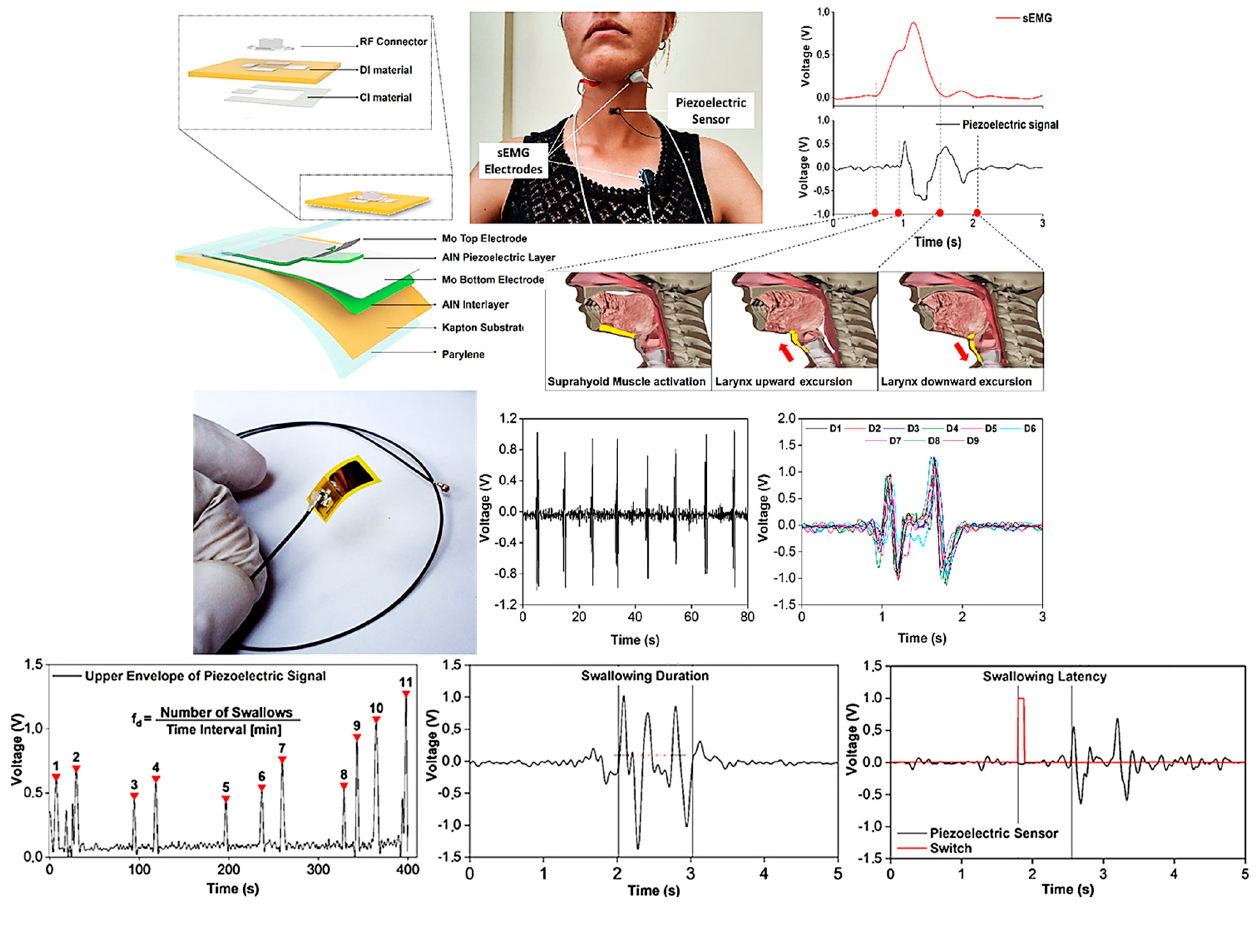
Figure 10. PVDF flexible sensor and the corresponding output voltage over time, and position for the detection of heartbeat, breathing, swallowing, and chewing. Additionally, maximum voltage values depending on the flexion levels of the finger, upper bending, lower bending, and wrist rotation are also reported ( a ) [21]. Flexible piezoelectric sensor with the corresponding exploded drawing showing the multilayered structure ( b ). Here the deglutition wave recognition and segmentation with the comparison of the sEMG recorded signals of a single swallow action are reported. Additionally, spontaneous frequency, duration time, and latency of a swallowing act are also displayed